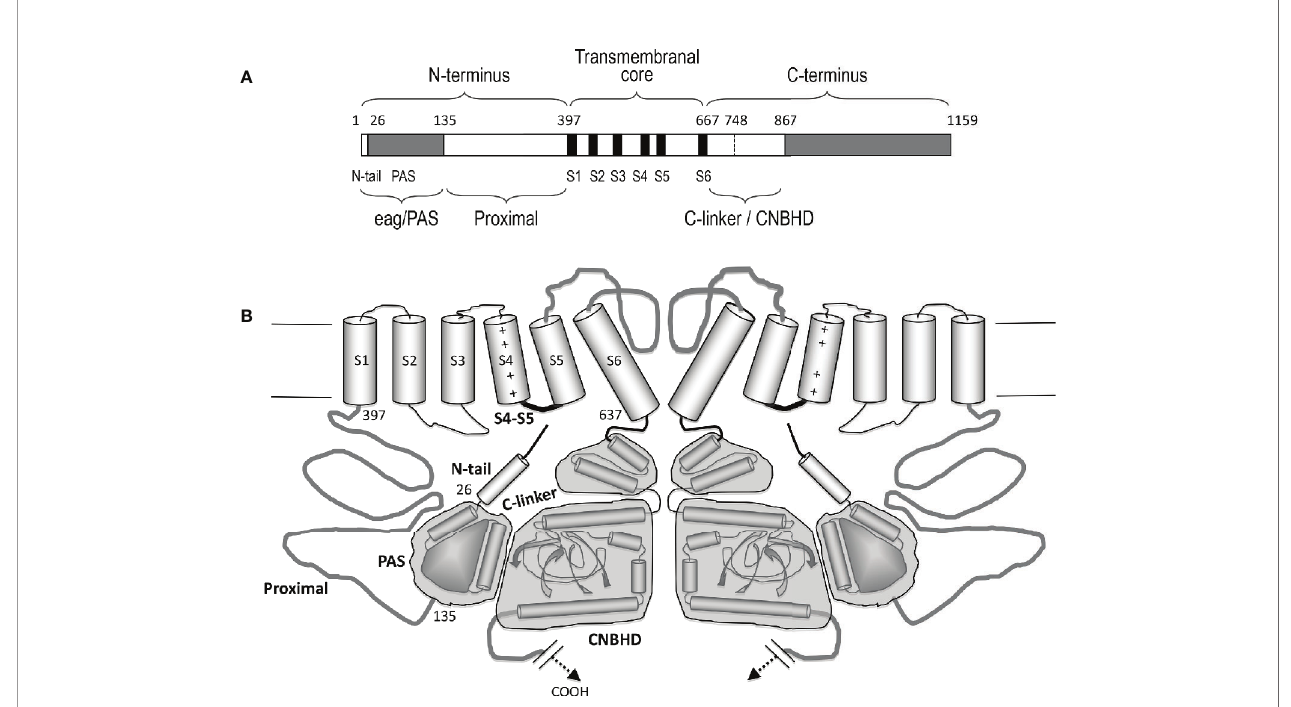
FIGURE 2 | Schematic representation of the structural organization of the erg1 (Kv11.1/hERG) channel. (A) Schematic linear diagram of an erg1 channel subunit. The six transmembrane helices (S1 to S6) are represented as black boxes. The position of the boundaries between the different channel domains denoted above and below the bar is indicated with numbers. The size of each region is represented approximately proportional to scale. (B) Schematic cartoon representing two a - subunits of a four-subunit erg1 channel tetramer. The S1 – S4 transmembrane helical segments that make up the voltage sensor domain are linked via an S4 – S5 linker (thick black line) to the pore-forming domains (segments S5 and S6 and intervening pore loop, thick grey line). Note the short length of the S4 – S5 linker associated to the non-domain-swapped organization of the transmembranal core. Both the N- and the C-terminal regions are intracellular. At the N-terminus, the amphipatic helix (residues 10 – 23) that follows the initial fl exible segment in the N-tail, and the PAS homologous domain (residues 26 – 134), are depicted as a small cylinder and a globular grey structure, respectively. The erg1 exclusive proximal domain of the N-terminus (residues 135 – 397) is represented as a grey line connected to the S1 helix. At the C-terminus, the C-linker and cyclic nucleotide-binding homology domain (CNBHD) domains are schematized, encompassed in grey blocks, as a pair of cylinders and as cylinders and sheets, respectively. The long distal region of the carboxy terminus that remains structurally uncharacterized and with no recognized direct in fl uence in channel gating, has been omitted for